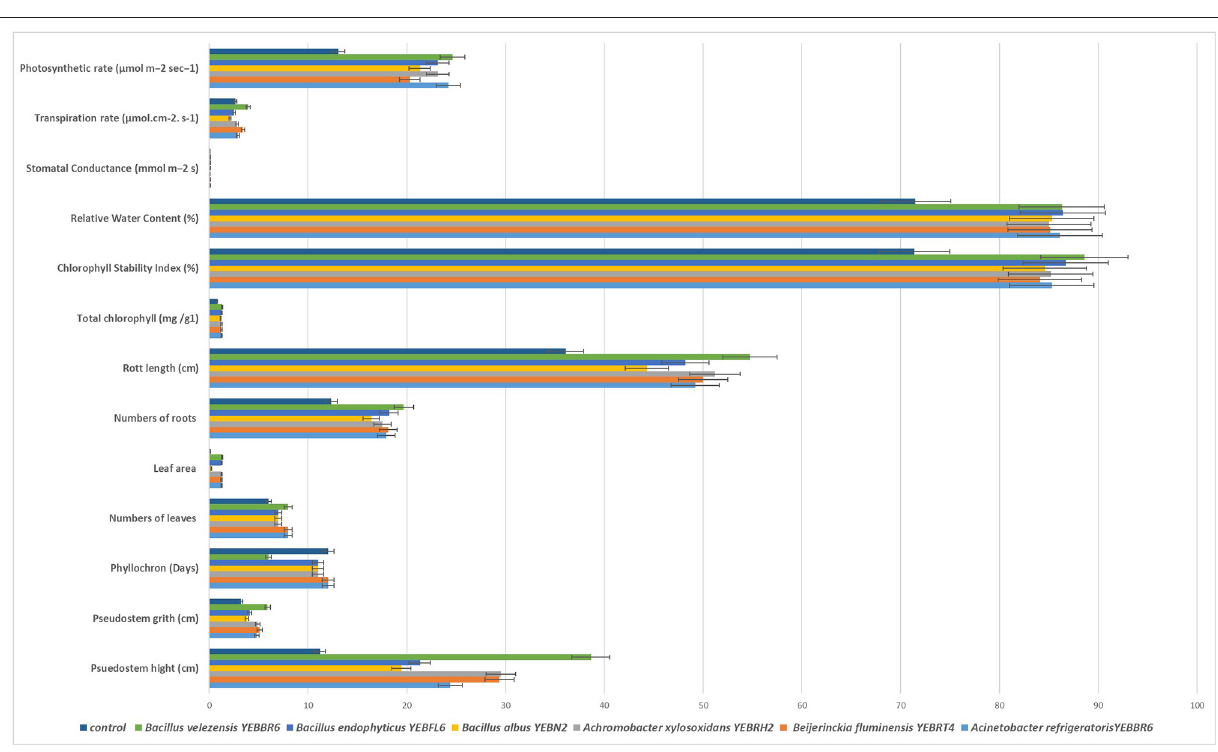
Frontiers in Sustainable Food Systems |